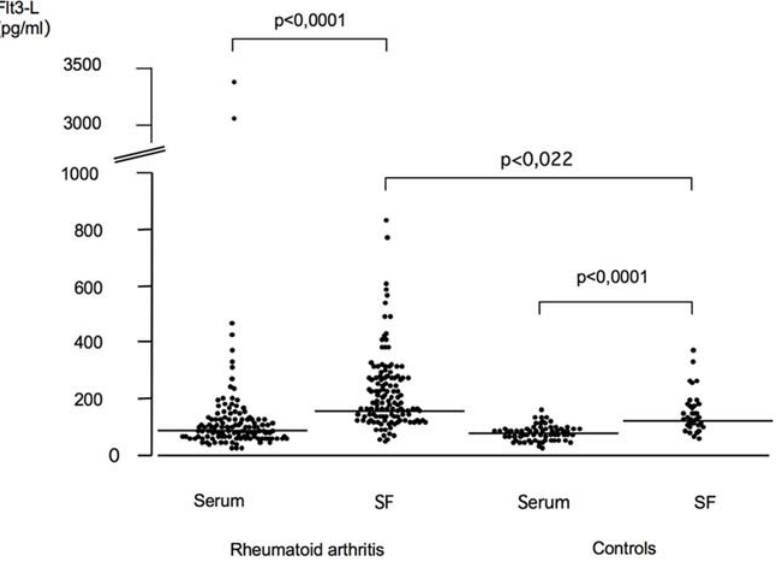
Figure 1. Flt3-L levels in synovial fluids and sera of RA patients and of control subjects . Median displayed in the horizontal line. RA serum (n=130, median 80, range (min 0–max 3320), RA SF (n=130, median 160 pg/ml, range (min 20–max 1980), control subjects serum (n=70, median 70.5 pg/ml, range (min 0–max 160), and control subjects SF (n=37, median 120 pg/ml, range (min 0–max 360).